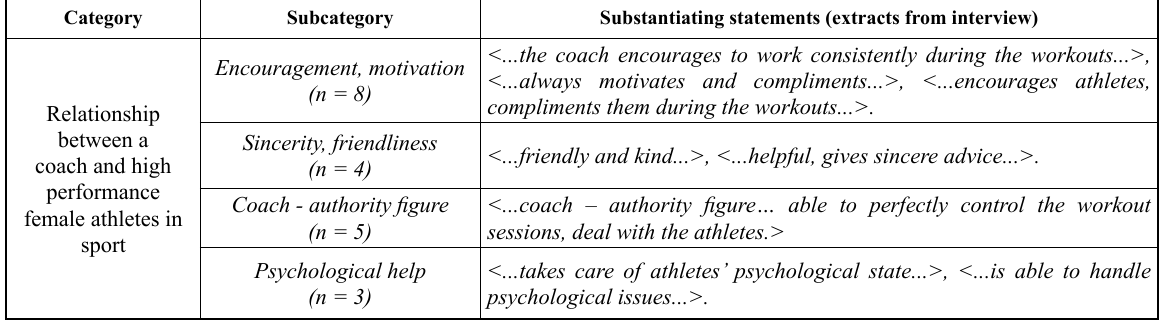
Table. Communication and cooperation of a coach and high performance female athletes Category